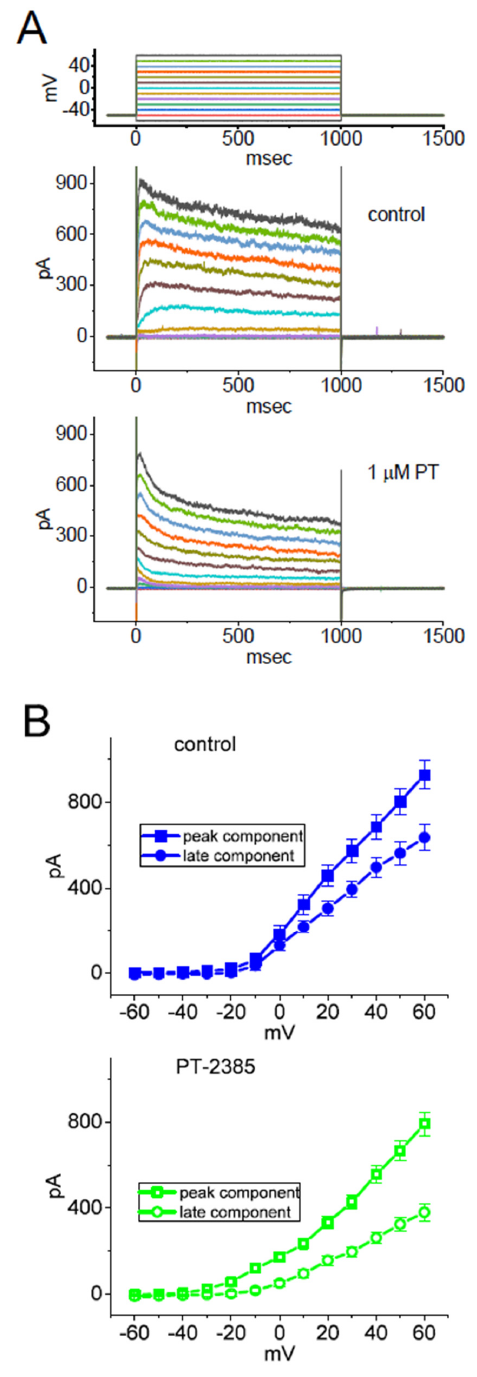
Figure 3. Effect of PT-2385 on mean the current versus voltage ( I-V ) relationship of I K(DR) in GH 3 cells. In these experiments, cell membrane potentials were held at − 50 mV, and the depolarizing command pulse to a series of voltage steps (1-s duration) ranging between − 60 and +50 mV in 10-mV increments (as indicated in the uppermost of ( A )) was thereafter applied to evoke the currents. ( A ) Representative current traces in the control period (upper image) and during exposure to 1 µ M PT-2385 (lower image). The current traces indicated in different colors with or without the presence of PT-2385 correspond to the potential ones in the uppermost part of ( A ). ( B ) Mean I-V relationships of I K(DR) taken before (upper image, blue-filled symbols) or after (lower image, green open symbols) 1 µ M PT-2385. The experimental data points in ( B ) were collected at the start (square symbols) or end-pulse (circle symbols) of the 1-s depolarizing voltage command. Each point represents the mean ± SEM ( n =